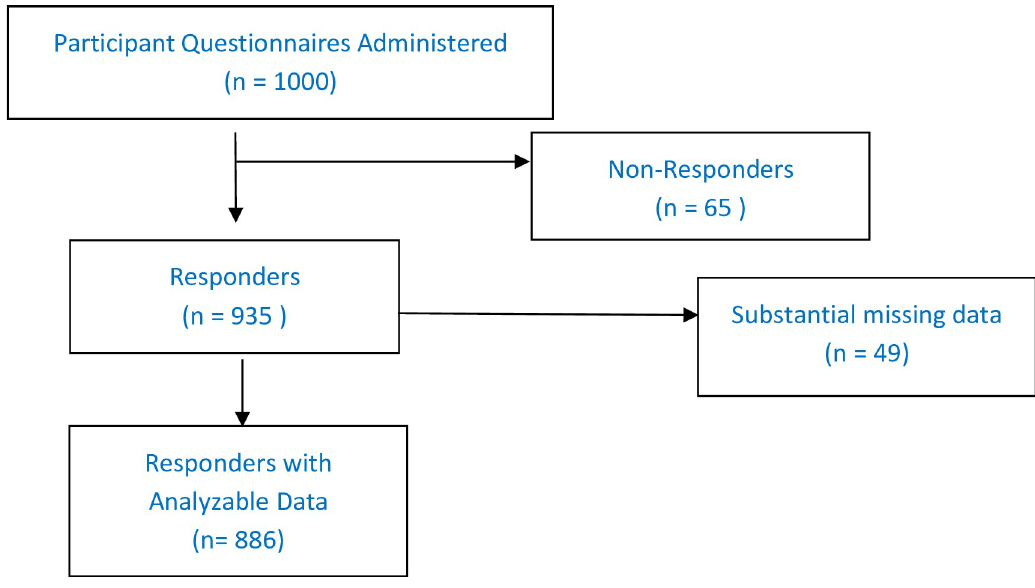
Fig 1. Flow diagram of participants recruitment.